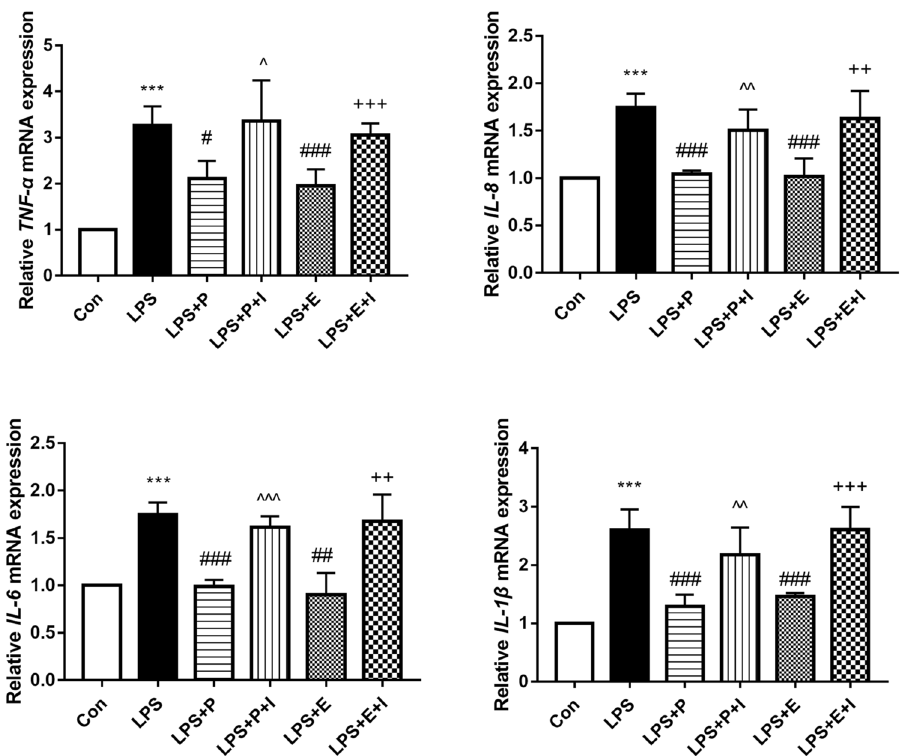
Figure 7. Effects of psoralen on the expression of inflammatory cytokines mRNA. hPDLCs were divided into 6 groups: Con, control group; LPS, LPS (1 μg/mL) group; LPS + E, LPS and estrogen (10 –8 M) group; LPS + P, LPS and psoralen (12.5 μg/mL) group; LPS + E + I, LPS and estrogen (10 –8 M) and ICI (1 μM) group; LPS + P + I, LPS and psoralen (12.5 μg/mL) and ICI (1 μM) group (* p < 0.05,** p < 0.01, *** p < 0.001 compared with the control group, # p < 0.05, ## p < 0.01, ### p < 0.001 compared with the LPS group, ^ p < 0.05, ^^ p < 0.01, ^^^ p < 0.001 compared with the LPS + P group, + p < 0.05, ++ p < 0.01, +++ p < 0.001 compared with the LPS + E